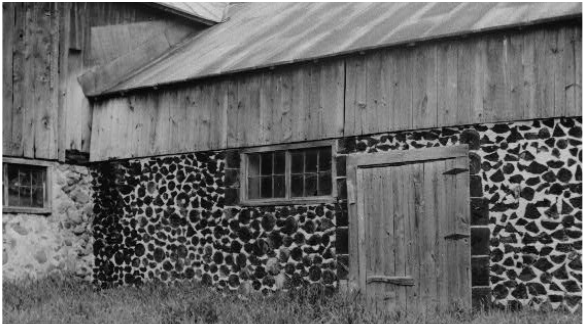
Figure 7. Wood Block Masonry Barn, No. 1, Lena, Oconto County, WI (Source: Library of Congress).